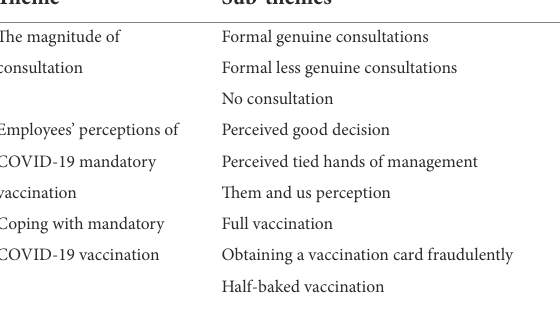
TABLE 2 Themes and sub-themes of